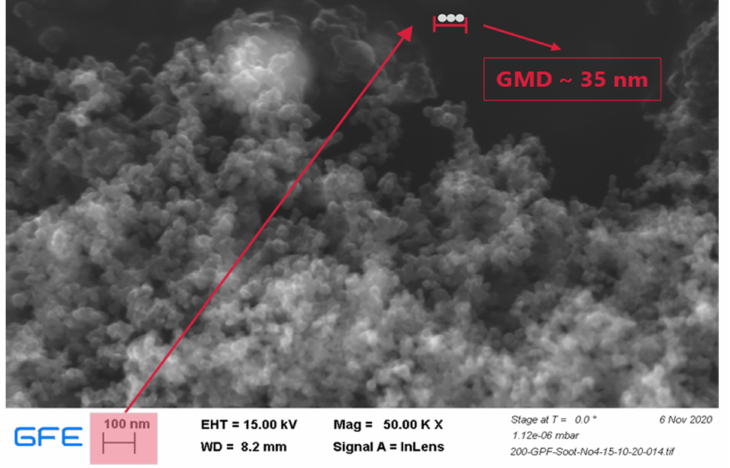
. m exh = 60 g/s, AFR = 0.95 and